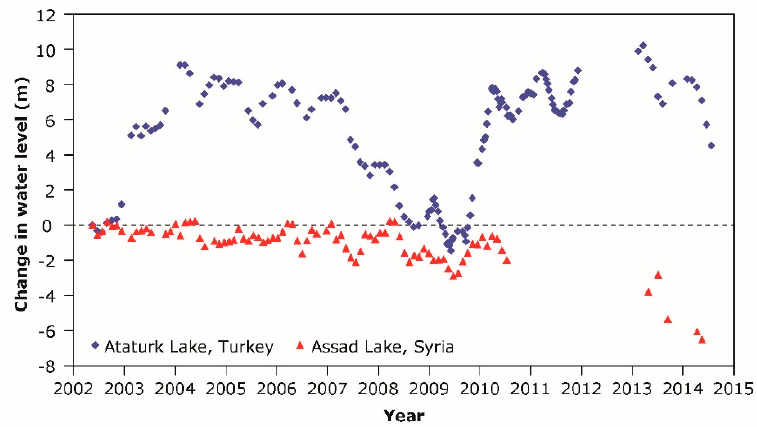
Figure 7. The temporal change of water levels in the Ataturk Lake (Turkey) and Assad Lake (Syria) relative to July 2002. Both reservoirs show a stable level until 2011 (except for the gap in Ataturk Lake between 2008 and 2010), while the water level in the Syrian lake gradually decreased after 2013. Data extracted from several space missions (http://dahiti.dgfi.tum.de/en/).